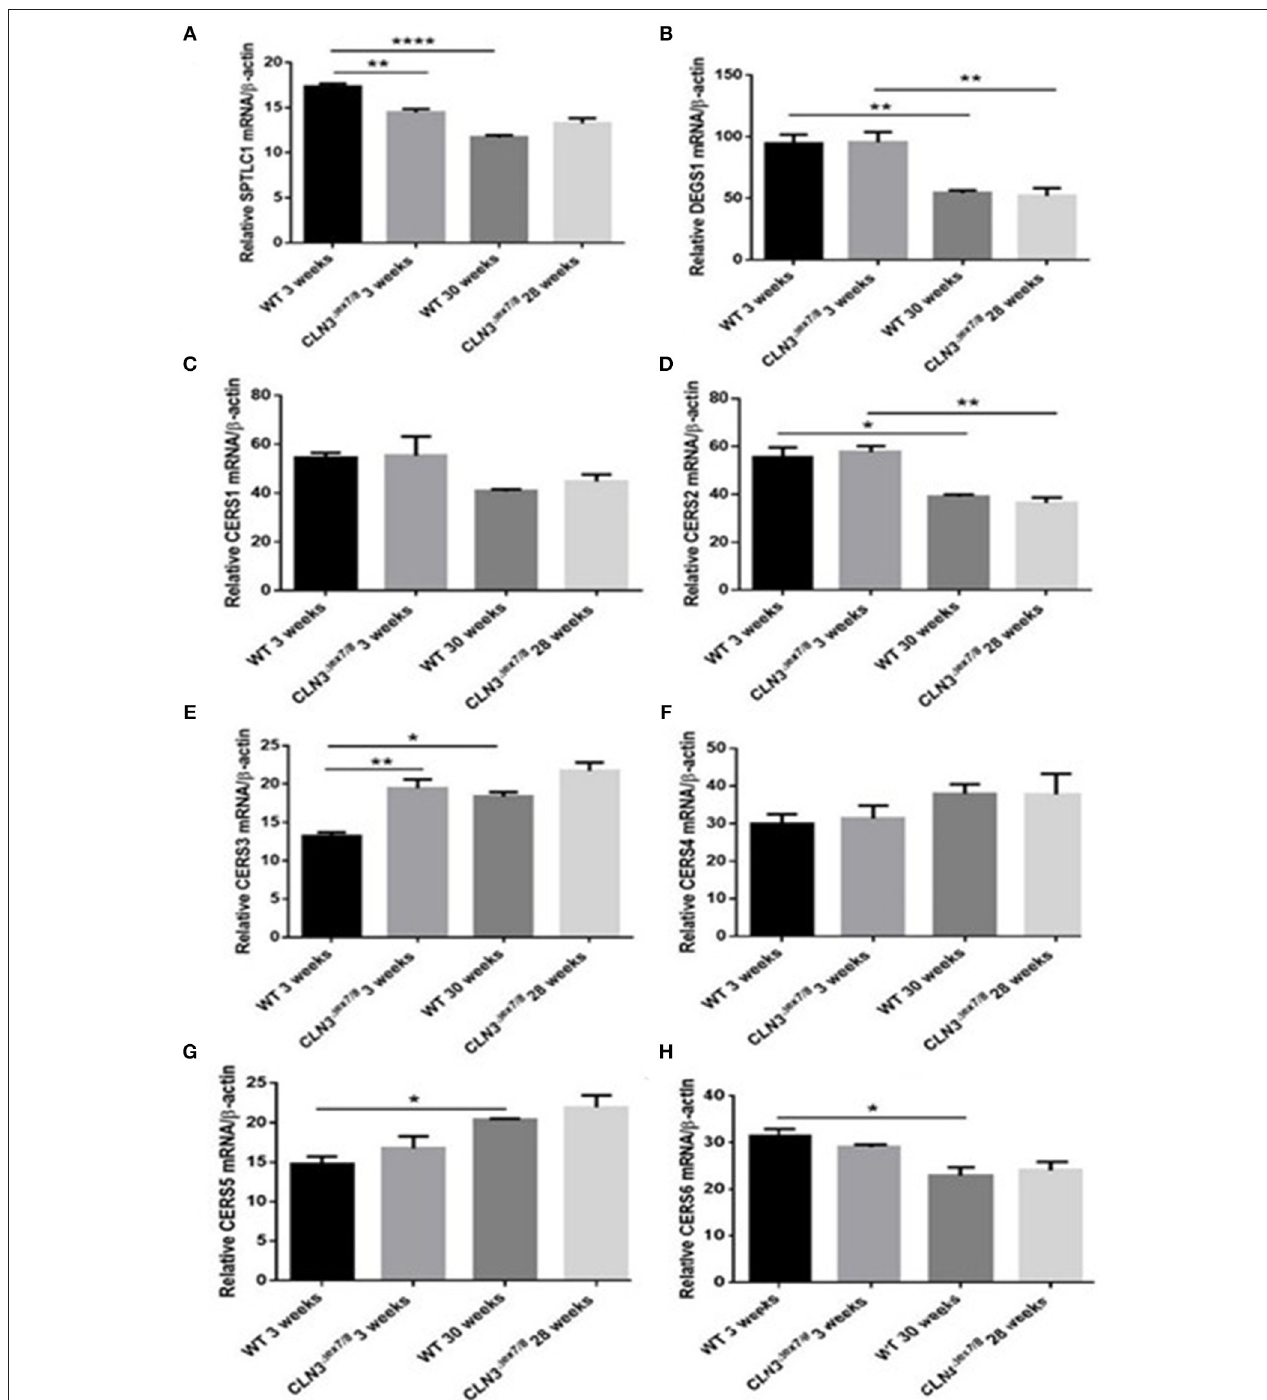
FIGURE 4 | Relative mRNA expression of de novo ceramide synthesis enzymes SPTLC1 (A) (** P < 0.01, **** P < 0.0001); DEGS1 (B) (** P < 0.01); CerS1 (C) ; CerS2 (D) (* P < 0.05, ** P < 0.01); CerS3 (E) (* P < 0.05, ** P < 0.01); CerS4 (F) ; CerS5 (G) (* P < 0.05); CerS6 (H) (* P < 0.05) in WT and Cln3 ∆ ex7/8 mouse brain at 3 and 28–30 weeks of age ( n = 3 in each group) by qRT-PCR. SPTLC1, DEGS1, CerS1, 2, and 6 are substantially upregulated in WT mouse brain at 3 weeks compared to 30 weeks of age. SPTLC1, CerS1, 3–6 show no significant change in expression between 3 and 28 weeks of age in Cln3 ∆ ex 7 / 8 mouse brain. Only DEGS1 and CerS2 expression were significantly greater at 3 weeks compared to 28 weeks of age in Cln3 ∆ ex 7 / 8 mice. The expression of de novo enzymes in Cln3 ∆ ex 7 / 8 mouse brain at week 3 differed significantly from that in WT mice in only two of the enzymes: SPTLC1 shows less expression in Cln3 ∆ ex7/8 mice compared to WT mice, and CerS3 is overexpressed in Cln3 ∆ ex 7 / 8 compared to age-matched WT mouse brain. At 28–30 weeks of age, differences in expression of de novo ceramide pathway enzymes in WT and Cln3 ∆ ex7 / 8 mouse brain were not statistically